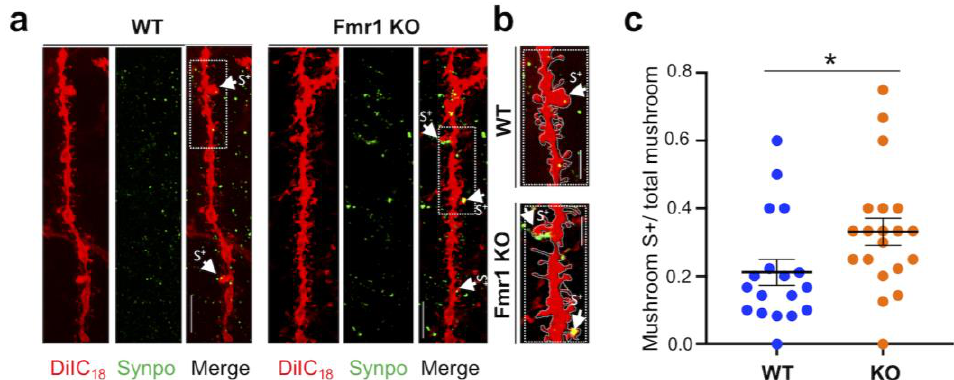
Figure 6. Increased abundance of mushroom spines containing Synpo in juvenile Fmr1 KO mice. ( a ) Representative confocal images of dendritic branches stained with DiIC 18 and immunolabeled with anti-Synpo from WT and Fmr1 KO hippocampi; scale bars, 5 µ m. ( b ) Magnified images of boxed areas in ( a ) i, scale bars 2 µ m. Arrows point to Synpo-positive (S+) mushroom spines. ( c ) Quantification of Synpo-positive (S+) mushroom spines relative to the total number of mushroom spines in WT and Fmr1 KO mice. Differences were evaluated by Student’s t -test * p = 0.038, from N = 3 mice per group.